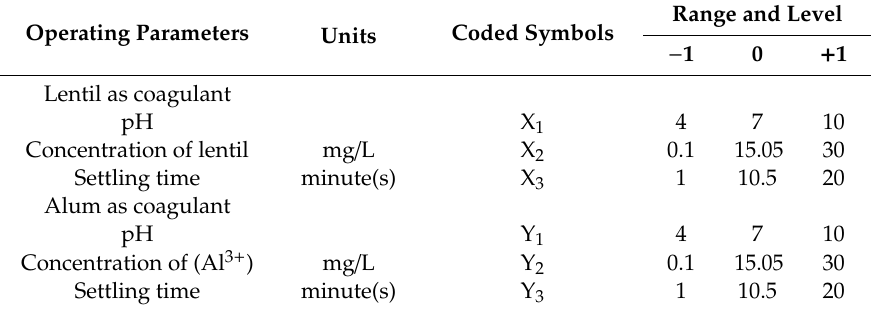
Table 1. Experimental domain of the Box–Behnken (BBD) design for using lentil or alum as